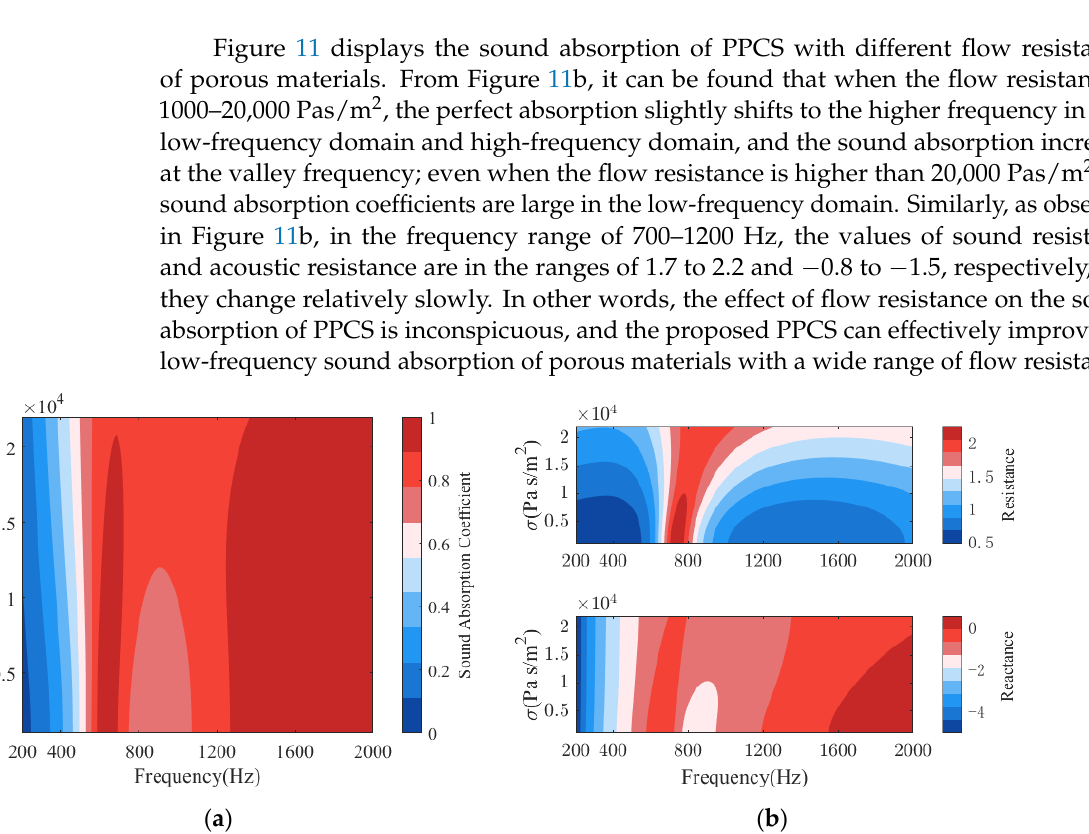
Figure 11. Effects of the flow resistance of PM on the sound absorption of PPCS: ( a ) sound absorption coefficients; ( b ) normalized surface acoustic impedance.